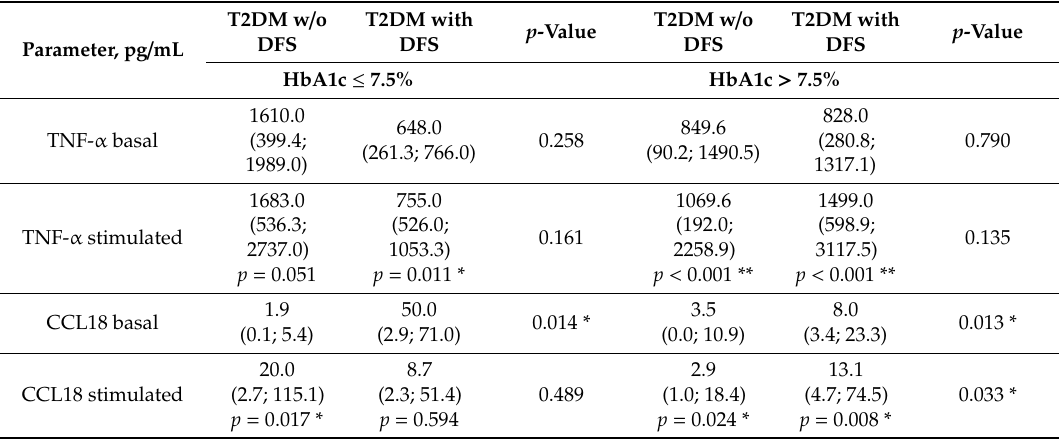
Table 3. Basal and stimulated TNF- α and CCL18 secretion by blood-derived monocytes from patients with long-term T2DM depending on HbA1c